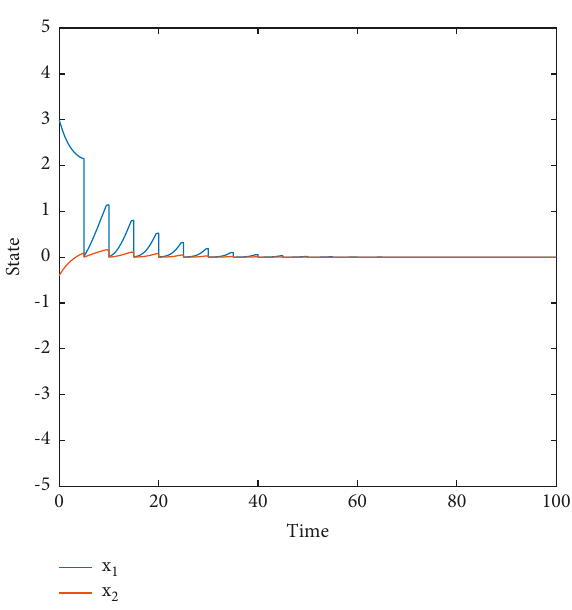
Figure 2: The state of (39) and (40) with τ � 4 .